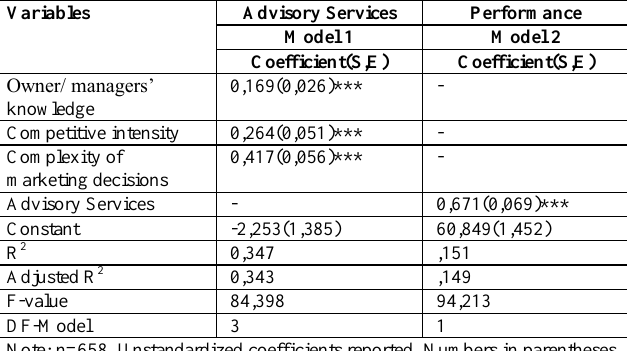
Table 3: Results of regression analyses for direct effect Variables